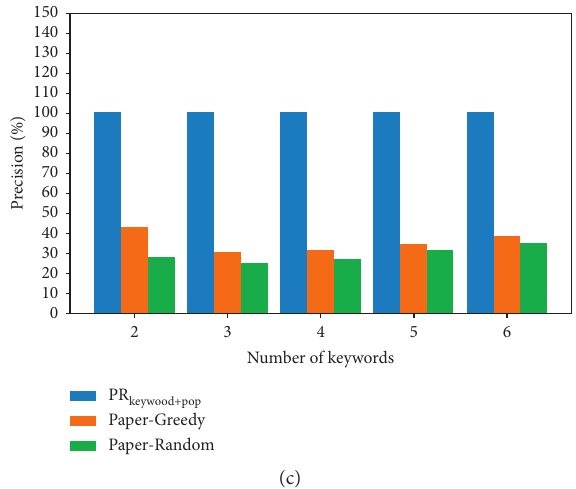
Figure 12: The precision of different approaches: (a) set A, (b) Tset B, and (c) set